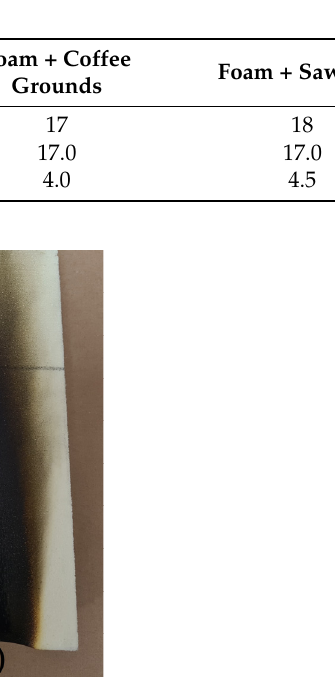
Figure 10. Photos of samples after the flammability test: reference sample ( A ), foam + coffee grounds 10 wt.% ( B ), and foam + sawdust 10 wt.% ( C ). Table 4. Flammability test